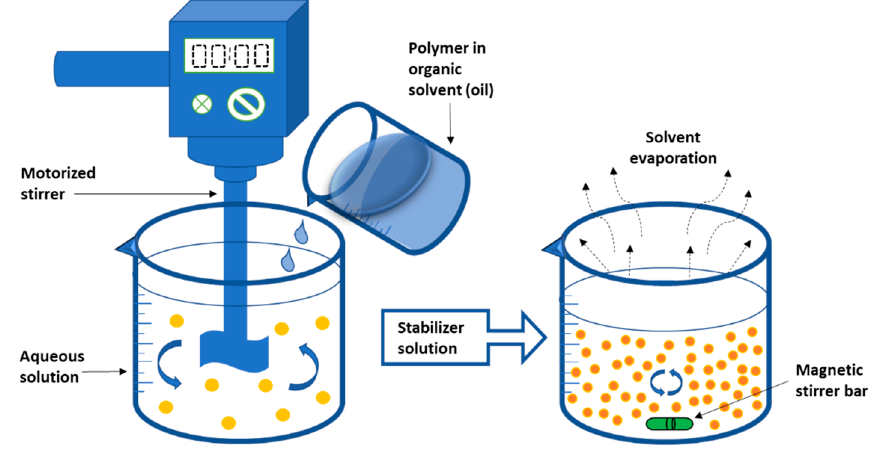
Figure 4. Diagrammatic representation of the emulsification solvent diffusion method.